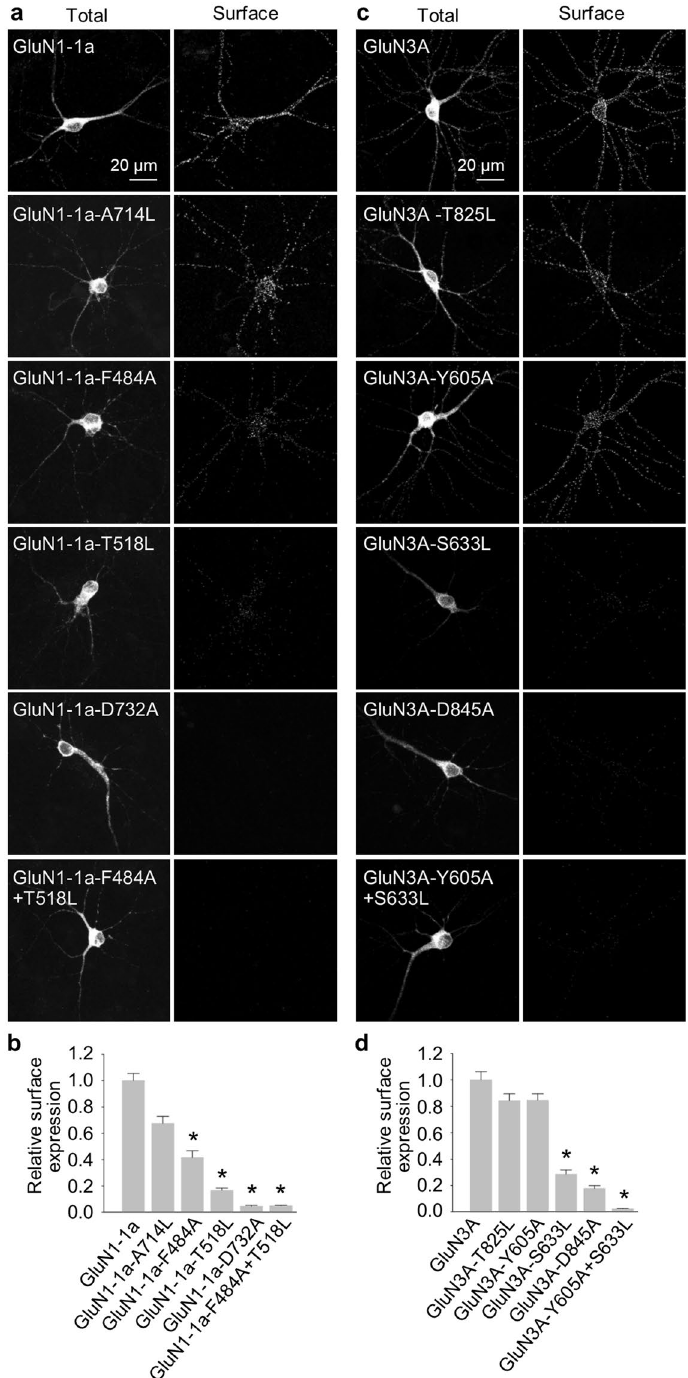
Figure 5. The glycine-binding sites in the GluN1 and GluN3A subunits regulate the surface expression of NMDARs in hippocampal neurones. ( a,c ) Representative images of cultured rat hippocampal neurones transfected at DIV10 with the indicated YFP-GluN1-1a (a) or GFP-GluN3A (c) subunits; at DIV14, surface and total subunits were stained using an anti-GFP antibody. ( b,d ) Summary of the relative surface expression of the indicated subunits measured in 10- µ m segments of secondary or tertiary dendrites (n ≥ 30 segments in ≥ 6 different cells per group); * p < 0.05 vs. GluN1-1a (b) or GluN3A (d )